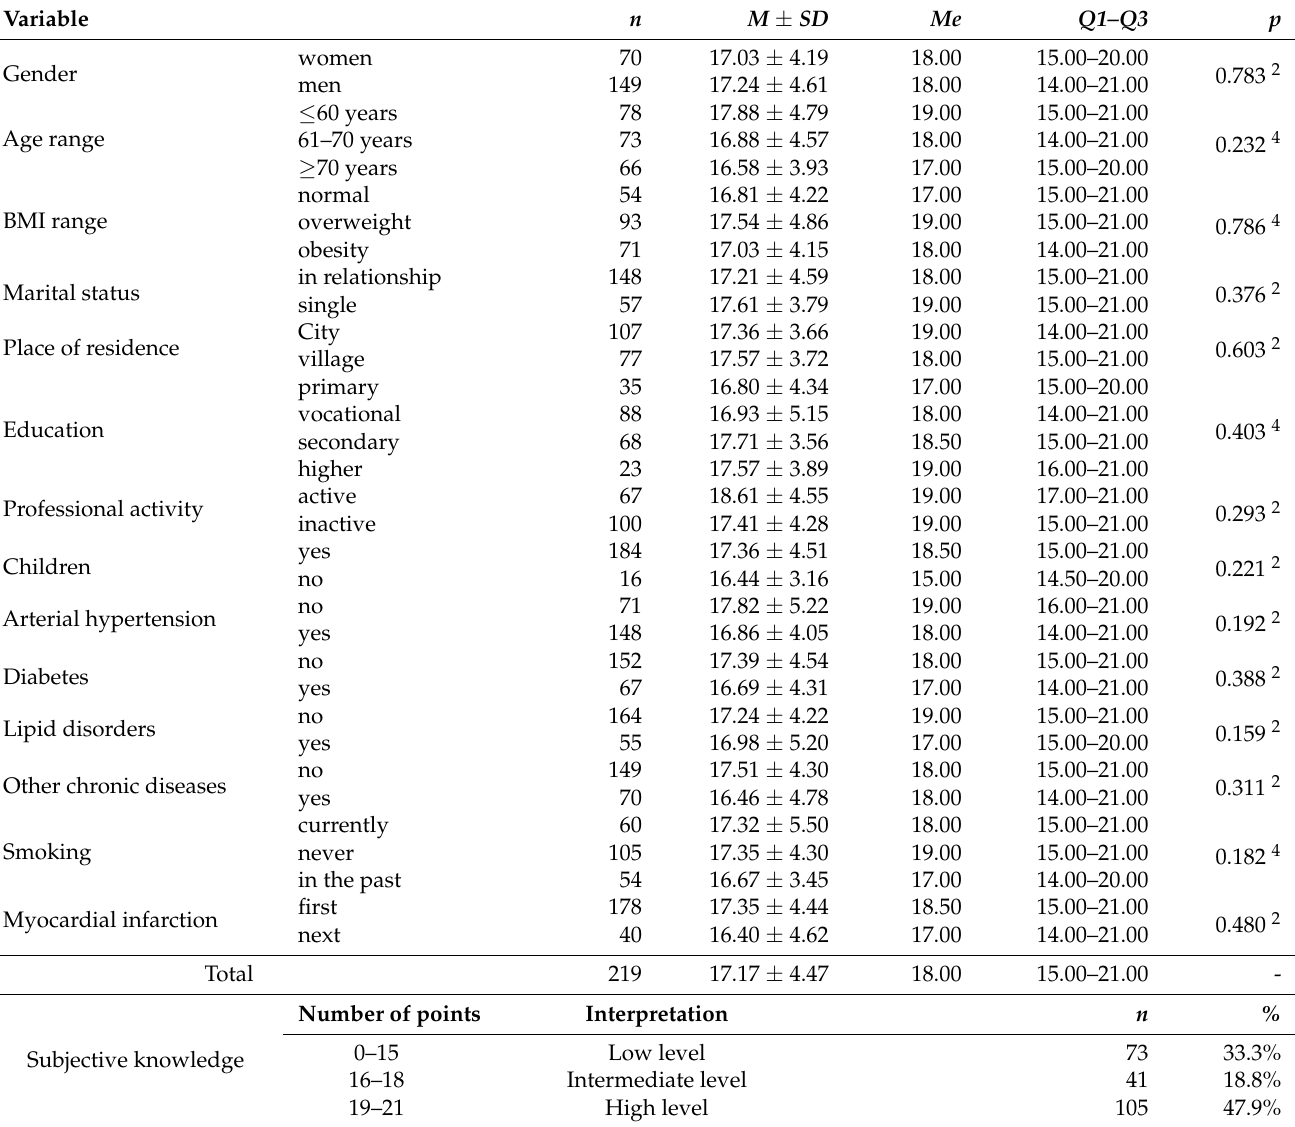
Table 2. The socio-demographic and clinical variables on subjective knowledge of the disease in MI